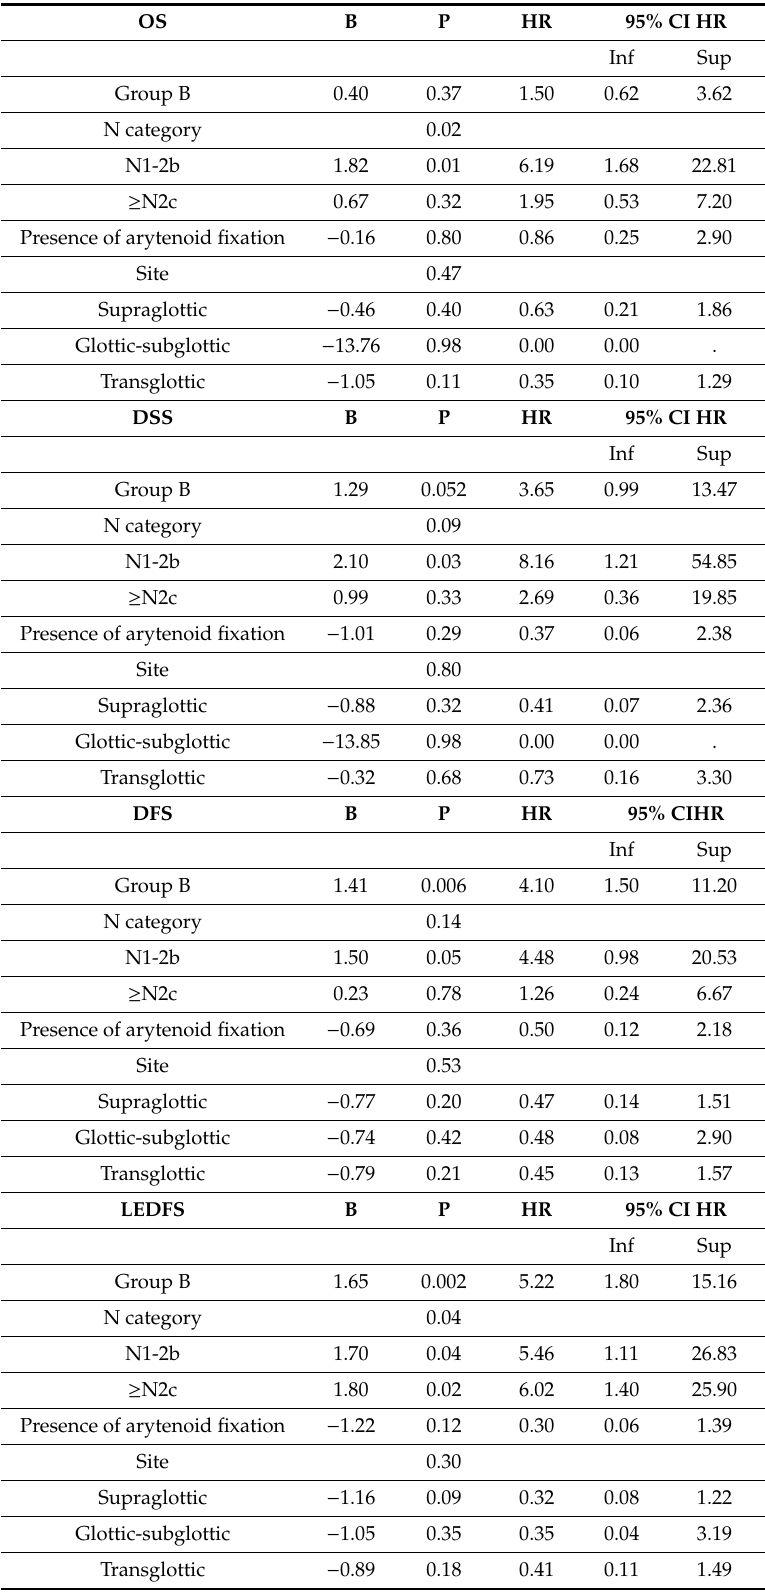
Table 3. Multivariate survival